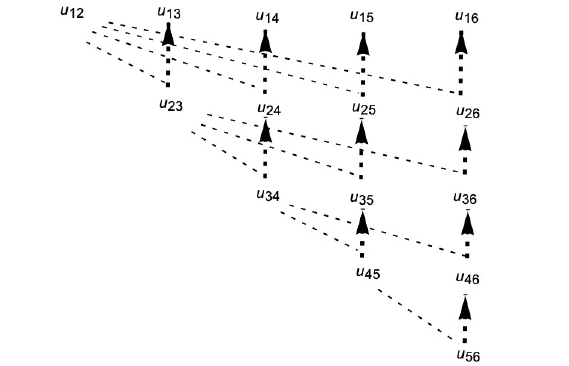
Figure 1 . The element indicated by the head of an arrow can be obtained from the sum of the two elements in the initial and middle points of the corresponding broken arrows. That relation, (1.30), implies that any element outside of the main diagonal can be written as a linear combination of the ones in the main diagonal: the seeds .